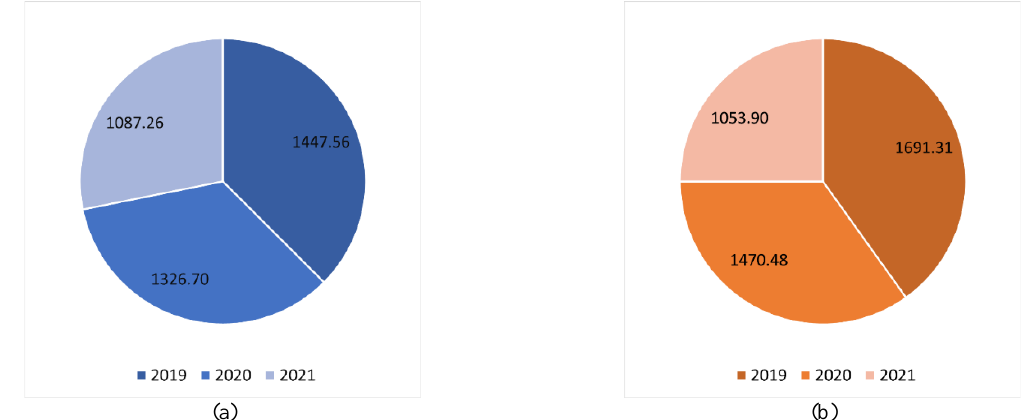
Figure 7. Mean water area changes in ISW for each year from 2019 to 2021 for (a) RF and (b) HA models. According to (a) Analyzing the annual changes, the water area of the wetland is decreasing, so that the average water area in 2019 was equal to 1447.56km², which in 2020 and 2021 decreased by 9% and 25%, respectively. And the average area of water area in these years has reached 1326.7km² and